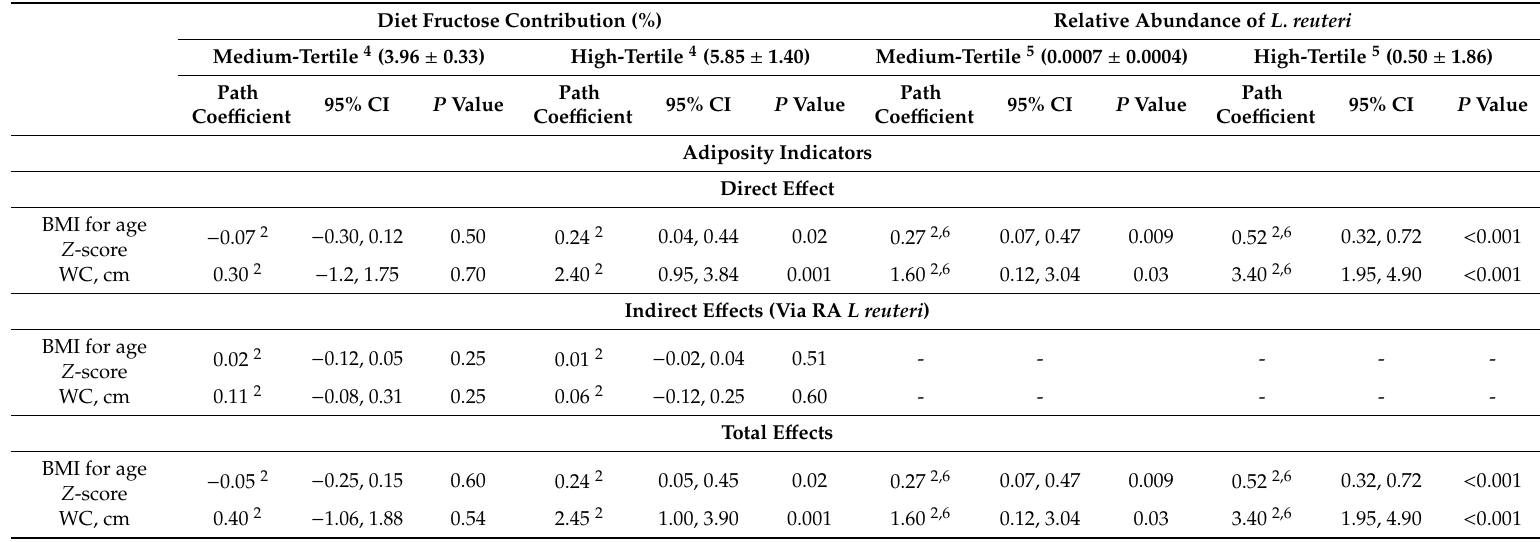
Table 2. Direct and indirect e ff ects of L. reuteri RA and diet fructose contribution on adiposity indicators and cardiometabolic markers in children of Mexico City 1